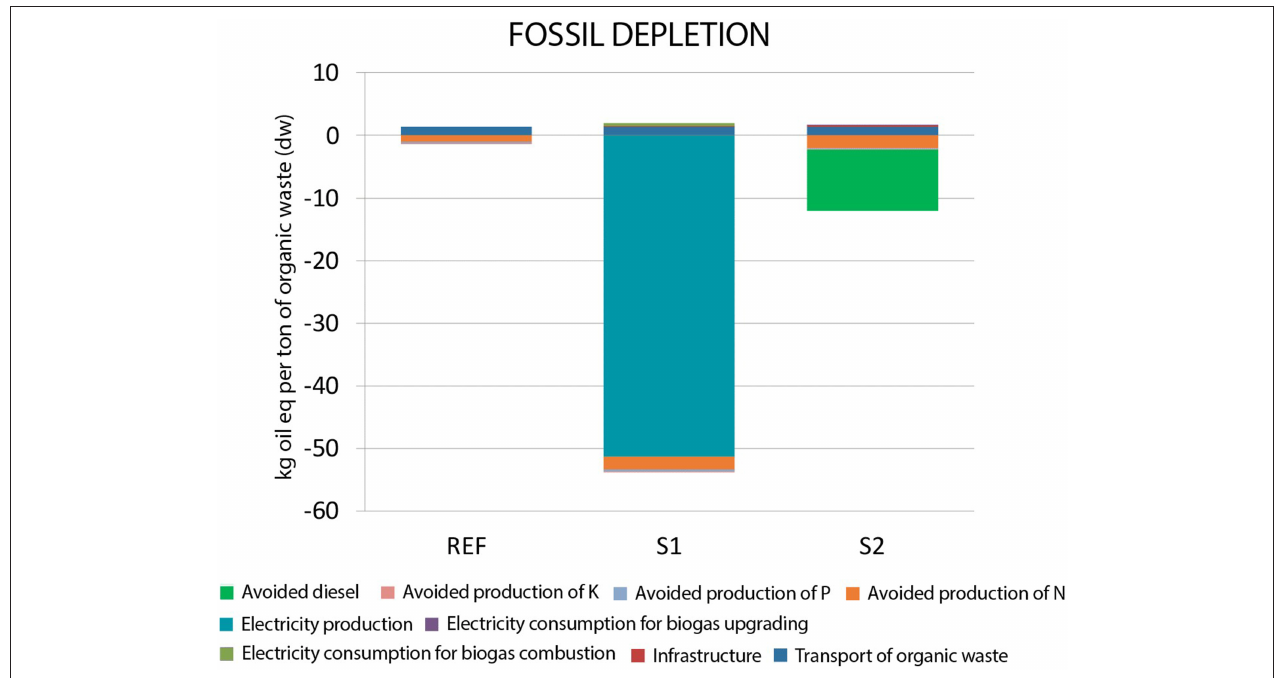
FIGURE 4 | Comparison of the reference and alternatives scenarios for the category of fossil depletion. Results are displayed as equivalent kg of CO 2 per ton of dry weight organic waste.